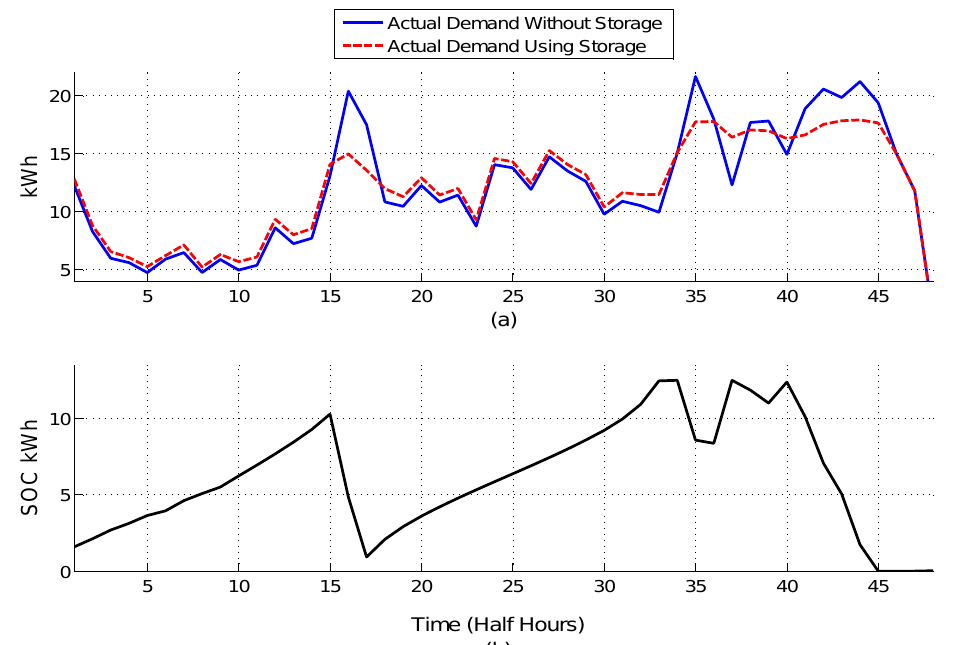
Figure 6. ( a ) The demand profile with and without a storage device; ( b ) the final SOC of the storage device throughout the